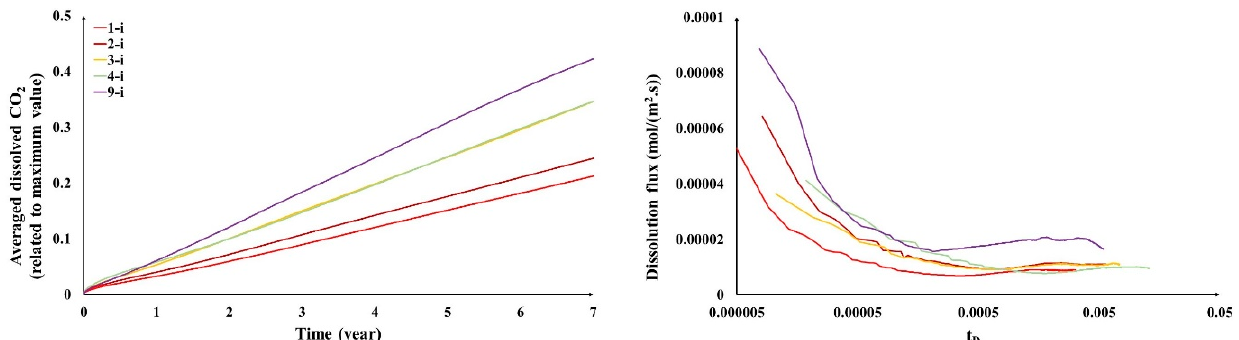
Figure 12. The averaged dissolved CO 2 and dissolution flux averaged for all the realizations of het-